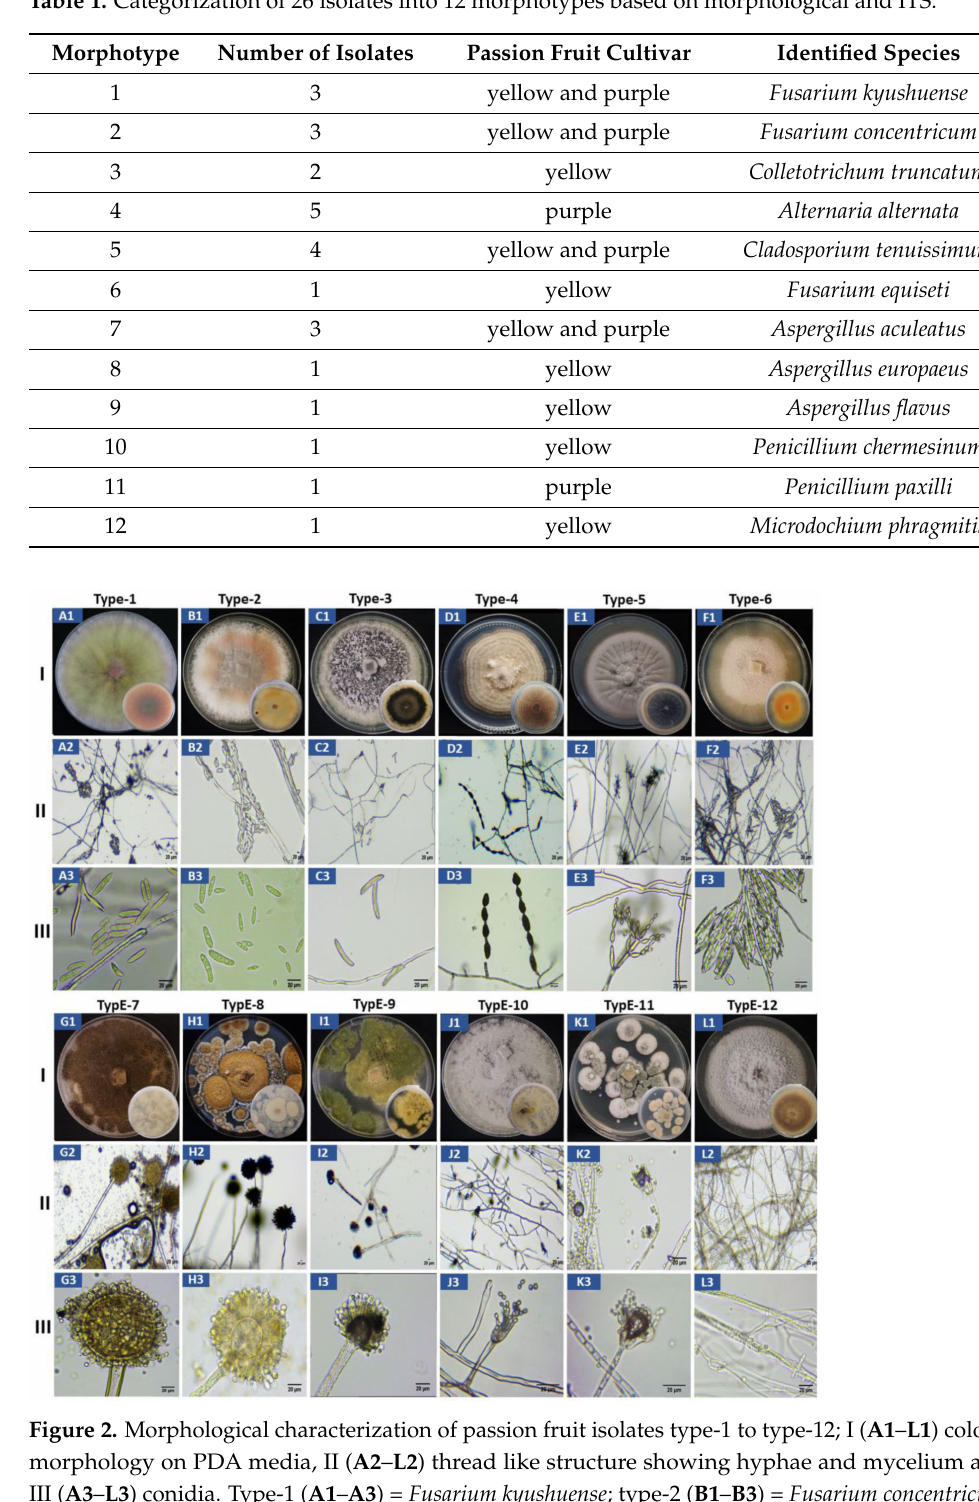
Table 1. Categorization of 26 isolates into 12 morphotypes based on morphological and ITS.